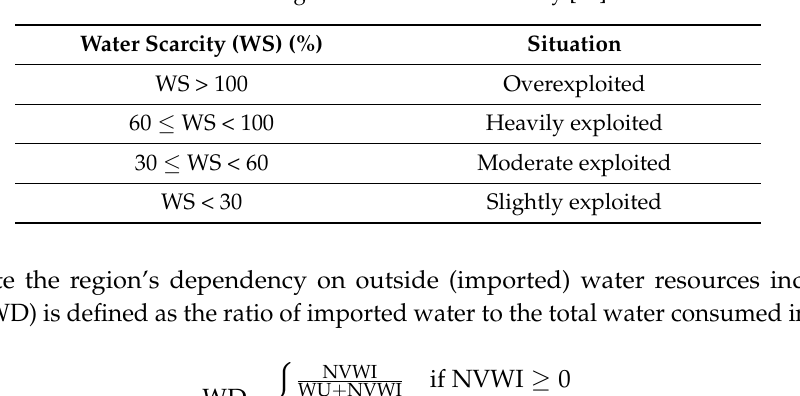
Table 1. Categorization of water scarcity